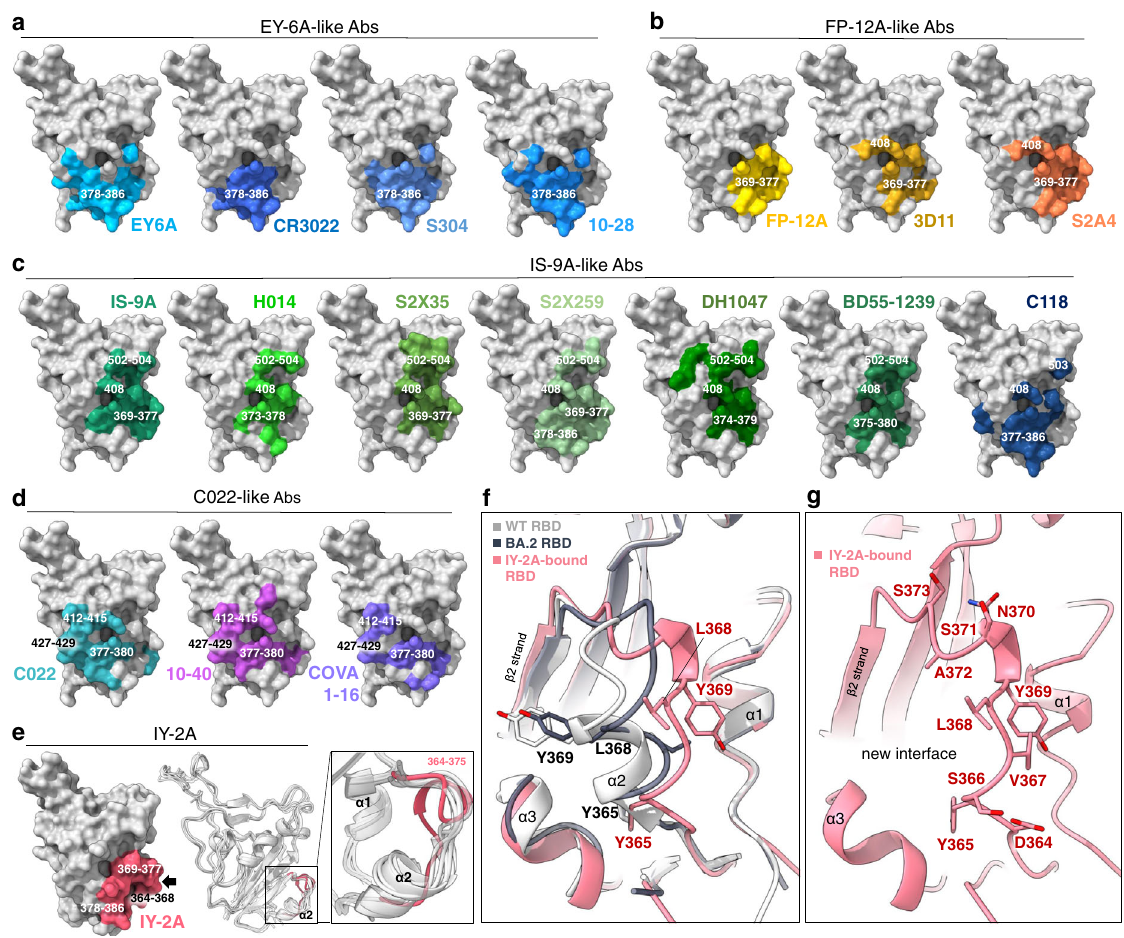
Fig.3|Structuralfootprintsofclass4antibodiesontheRBDandaninduced fi t ofRBDbyIY-2A. Footprintsofeachclass4antibodyontheinternalsurfaceofRBD are shown. The footprint includes all the residues that are directly involved in hydrogen-bond (2.5-3.5Å), salt-bridge (<4Å), or hydrophobic (3.3-4.0Å) interac- tioninthestructure. a EY-6A 6,14 andsimilarantibodiessharethebindingsitearound theresidues378-386region.PDBcode6ZERforEY-6A,6W41forCR3022,7R6Xfor S304 and 7SI2 for 10 – 28. b FP-12A and similar antibodies share the binding site around the residues 369-377 region, with some reaching residue 408. PDB code 7M7B for 3D11 and 7JVA for S2A4. c IS-9A and similar antibodies extend their footprintsupwardsand contact residue 408 and the residues502-504 region. PDB code 7CAH for H014, 7R6W for S2X35, 7M7W for S2X259, 7LD1 for DH1047, 7WRL